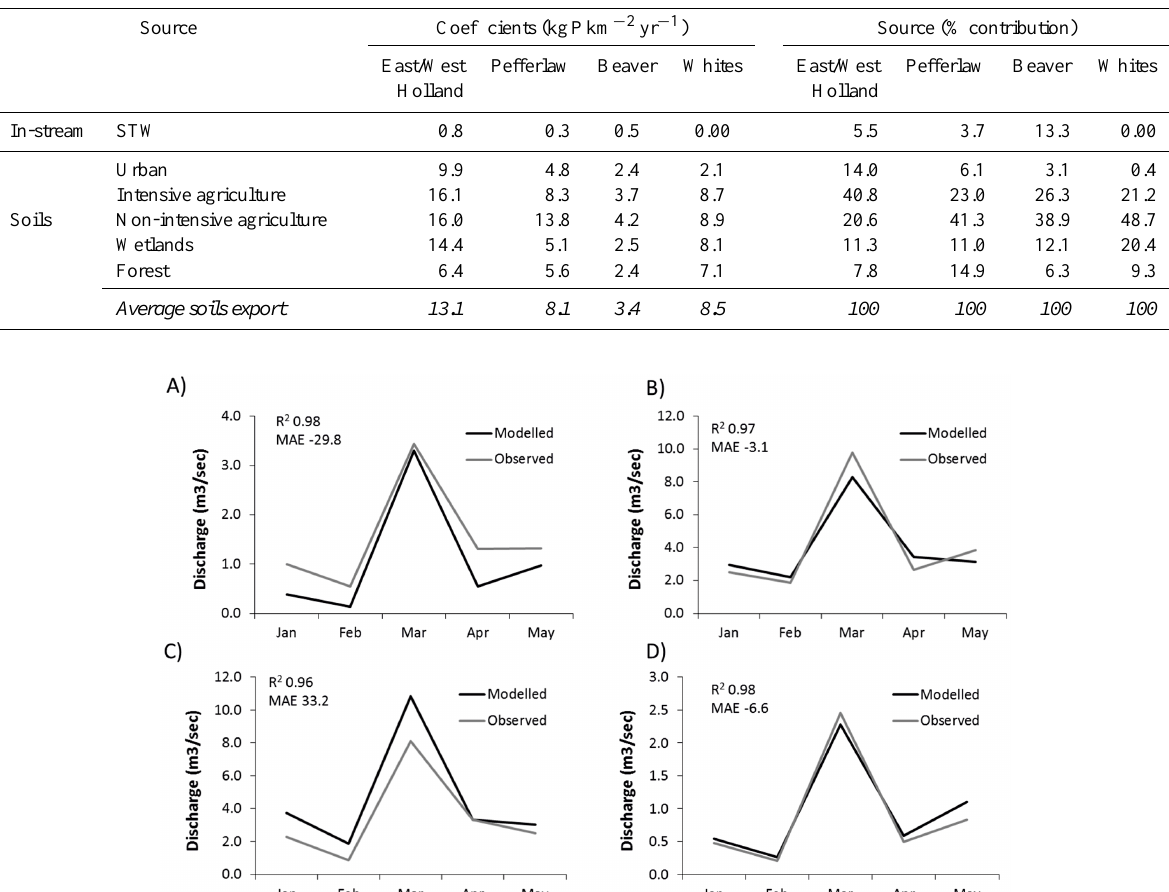
Table 5. Export coefficients (kgkm − 2 yr − 1 ) of total phosphorus from diffuse and point sources, and contributions of each source as a percentage of total phosphorus export (1d.p.).